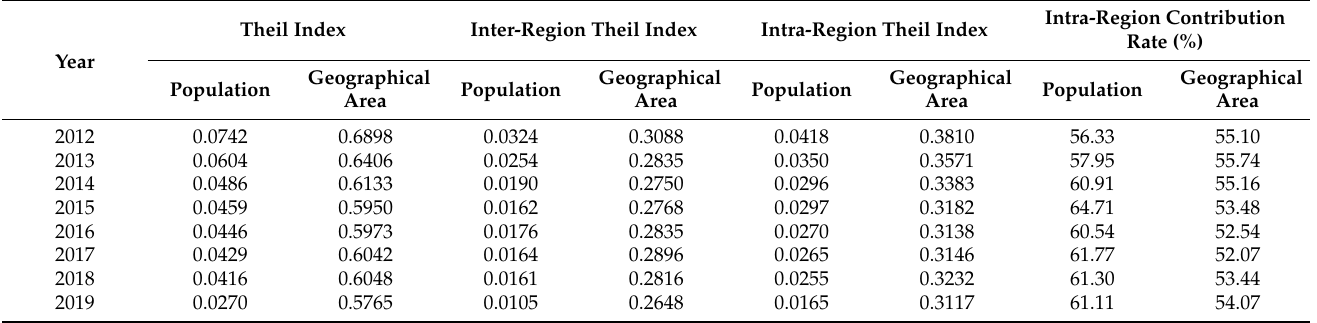
Table 7. Theil indices of Chinese GPs in 2012–2019.